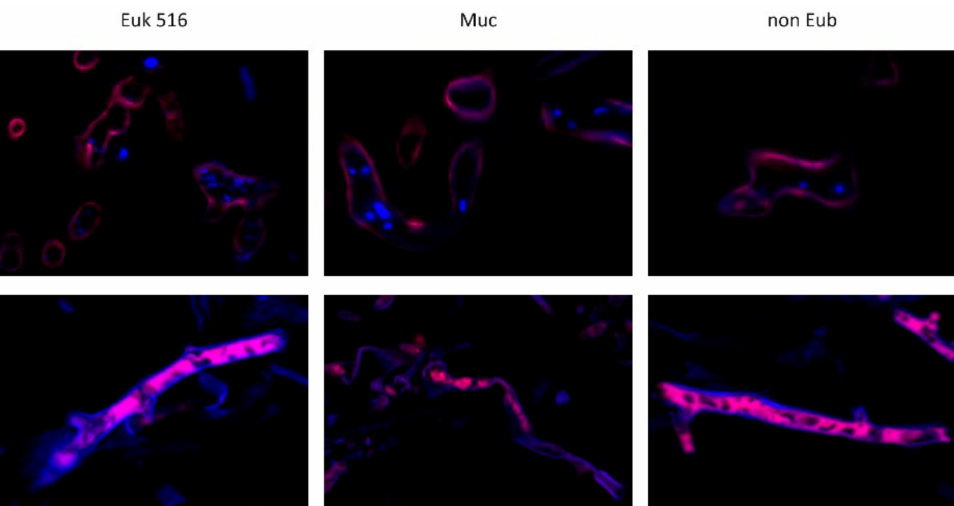
Figure 3. Unspecific fluorescence patterns in clinical samples with proven mucormycosis. Lack of cytoplasmatic hybridization signal (fluorescence in Cy5 channel) but fluorescence signal of fungal cell wall (Cy5 and Dapi channel) after hybridization with target probes and nonsense probe suggesting autofluorescence of the fungal cell wall (sample 11, upper row). Non-specific fluorescence in the DAPI and Cy5-channel of the cell wall and fluorescence signal localized in hyphal cytoplasm with all tested probes (sample 5, lower row). Fluorescence signal with nonsense probe non Eub and after RNAse treatment (pictures not shown) suggests that detected fluorescence within these samples is not due to hybridization of Cy5-labeled probes to the rRNA